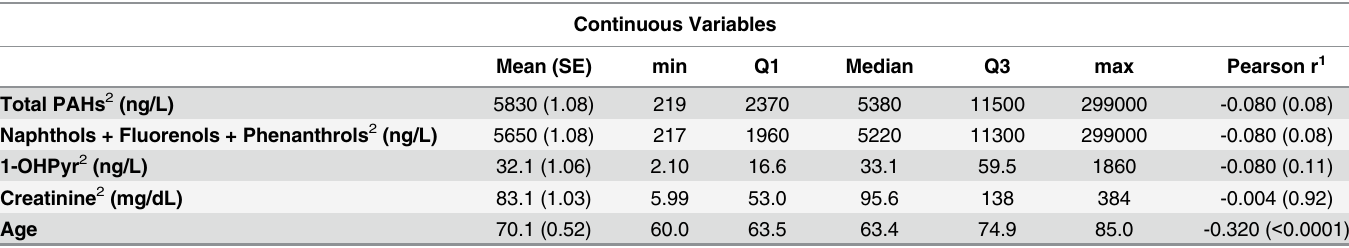
Table 2. Means and Standard Errors for Continuous